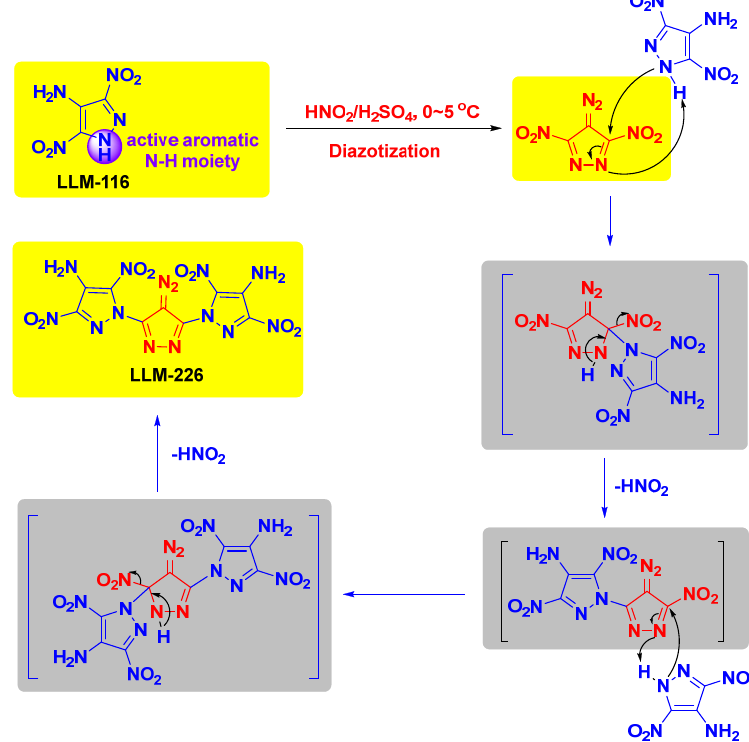
Figure 1. The synthesis of LLM-226 based on self-coupling of LLM-116.